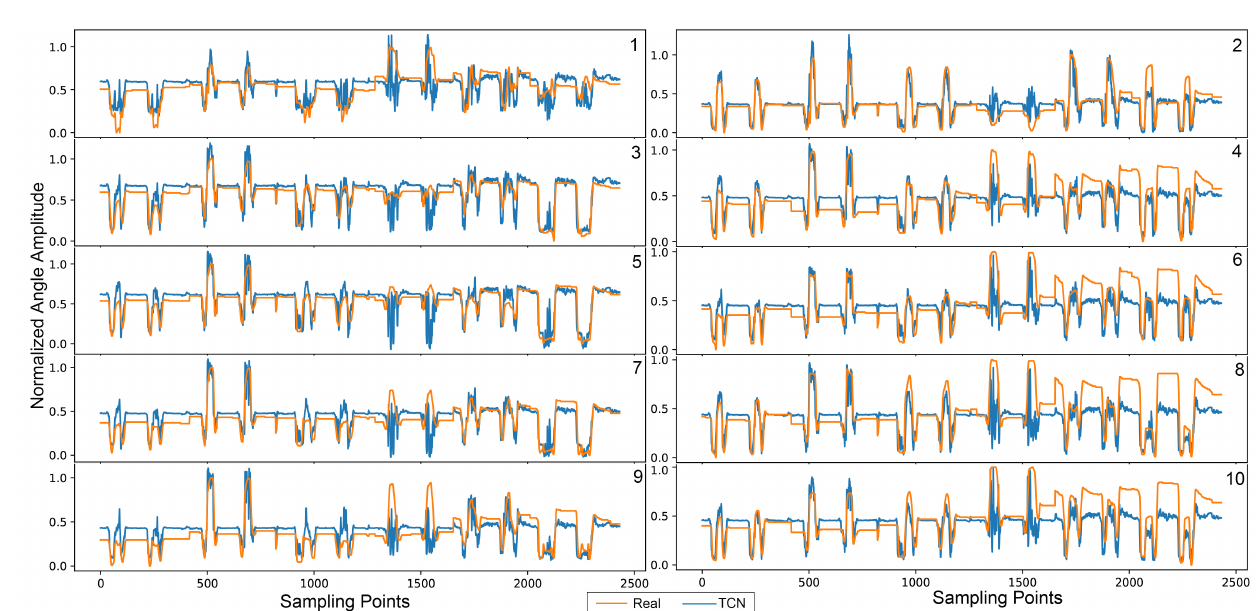
Figure 10. The continuous amplitudes of real and predicted joint angles using TCN (kernel = 3). There are 10 subfigures for 5 fingers (i.e., two joints per finger as depicted in Figure 2), and each subfigure denotes the result of a finger joint, where the x-axis represents the sampling point index and the y-axis denotes normalized joint angles. Each movement was performed twice, and thus every two peaks or valleys represents a movement; i.e., 6 grasping movements were characterized by 12 peaks/valleys in each subfigure.